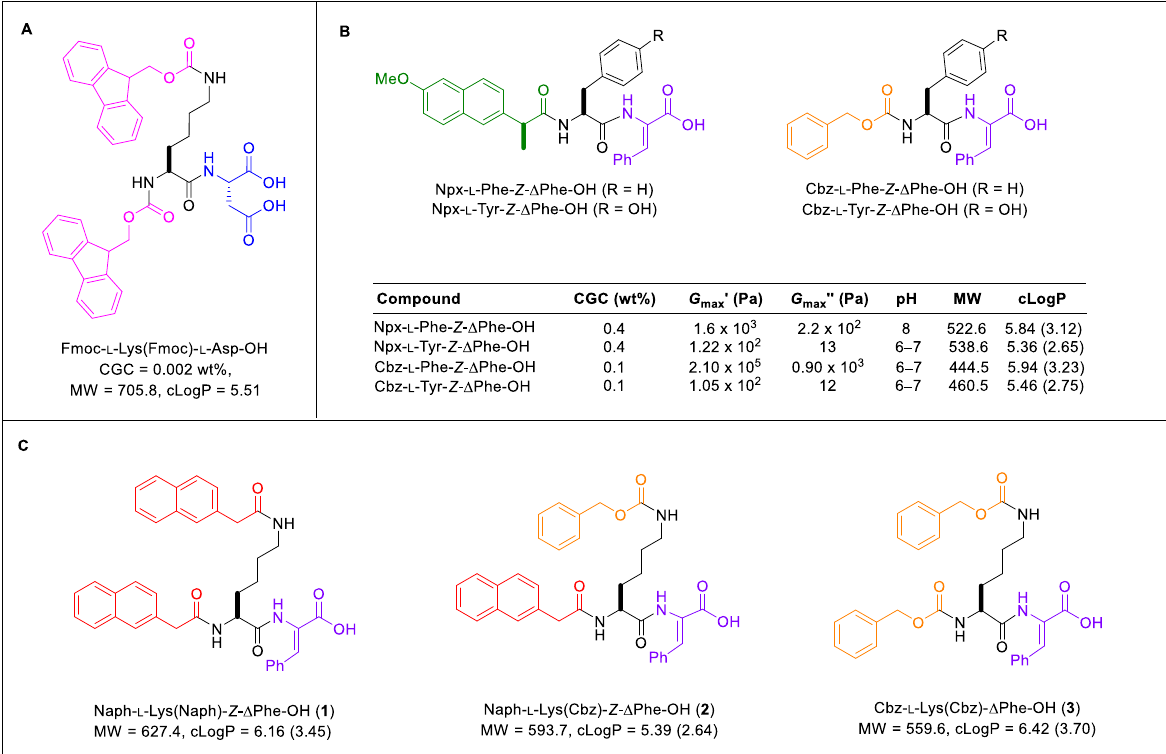
Figure 1. ( A ) Structure of Gazit’s dipeptide ‘ultragelator’. ( B ) A summary of the gelation properties of our previously studied dehydrodipeptides. ( C ) The structures of the dehydrodipeptides 1 – 3 to be studied in this work. cLogP value were obtained using https//molinspiration.com, accessed on 9 May 2022 (the values in parentheses refer to deprotonated carboxylate salt